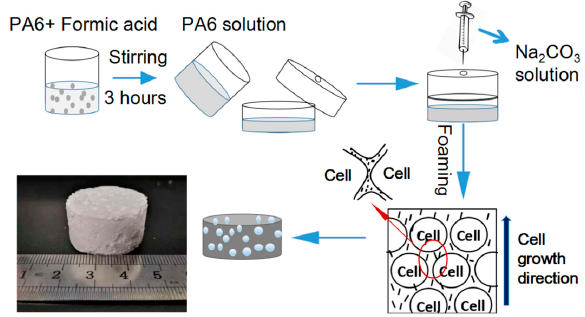
Figure 1. Scheme of preparation procedure of porous PA materials.